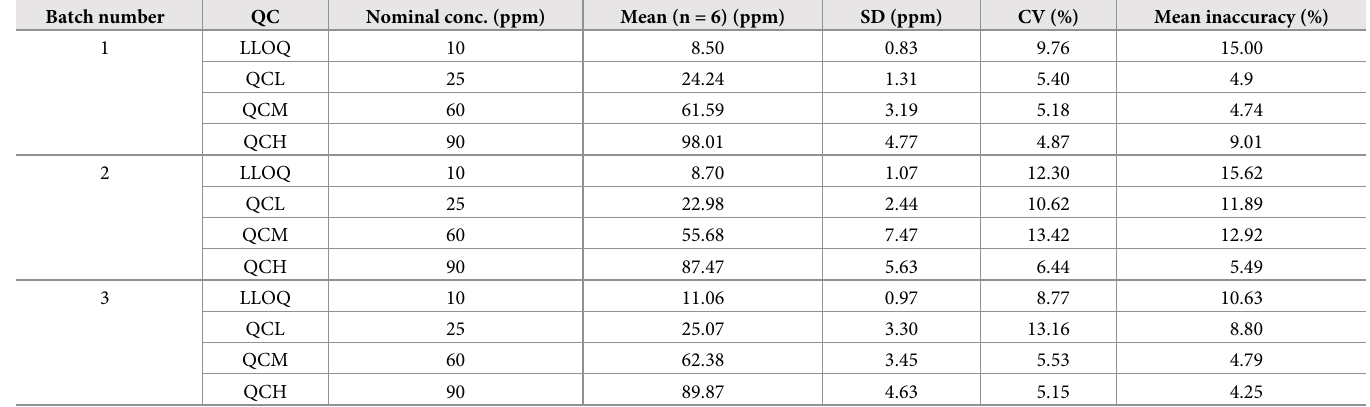
Table 7. Within-assay coefficients of variation and mean inaccuracies. Batch number